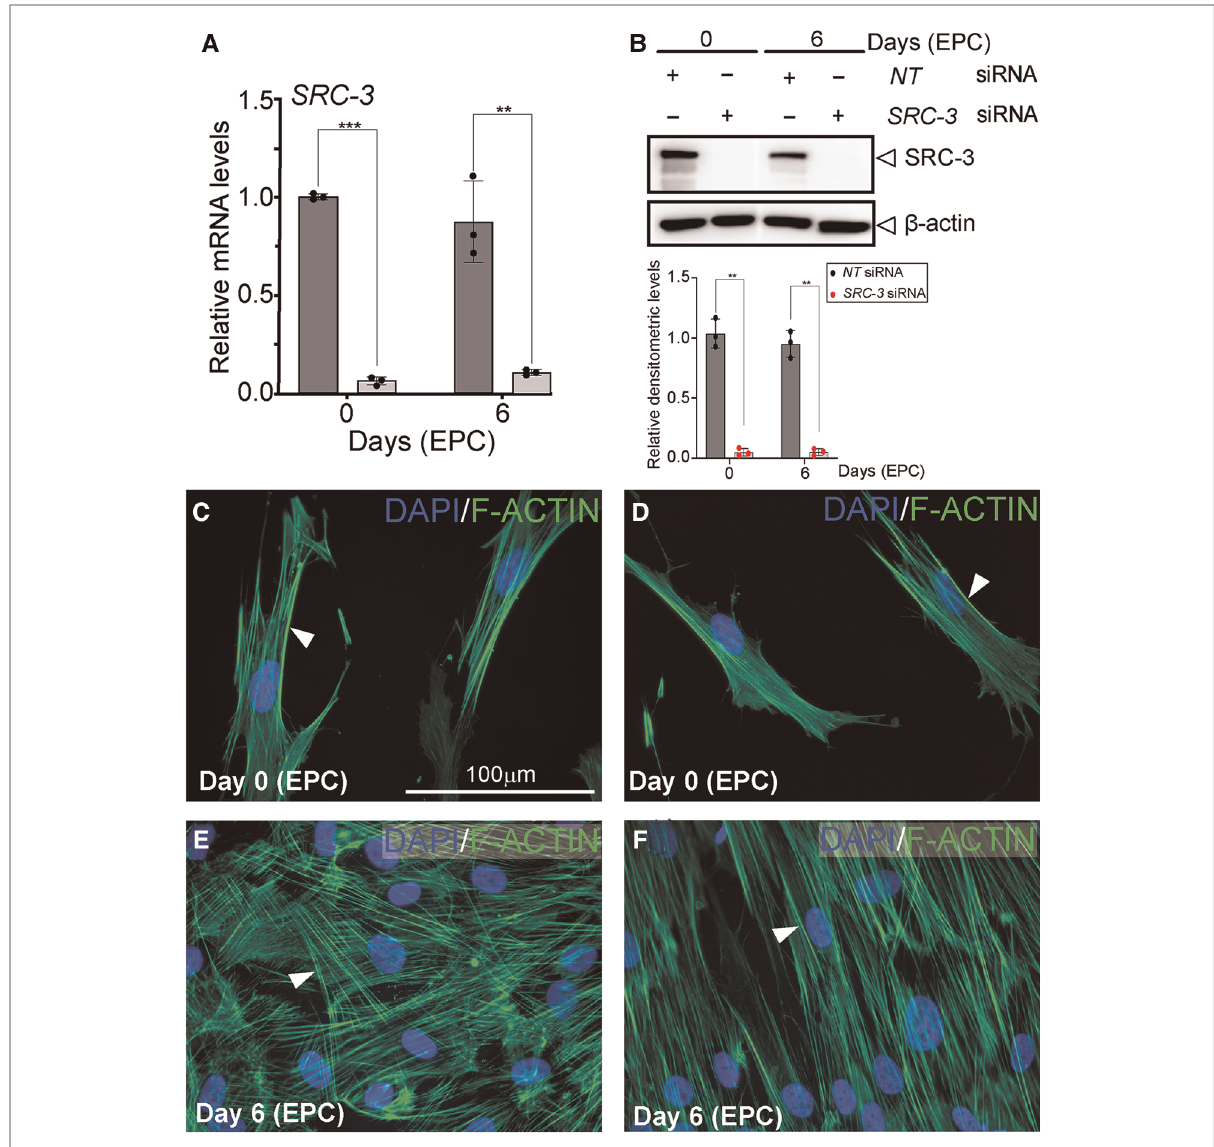
FIGURE 3 Decidualization of T-HESCs requires SRC-3 expression ( A ) siRNA mediated knockdown effectively reduces SRC-3 levels in T-HESCs both at day 0 and day 6 of EPC culture. The histogram ’ s dark grey bar on the left indicates T-HESCs transfected with NT siRNAs whereas the light grey bars on the right denote T-HESCs transfected with SRC-3 siRNAs. Note the persistent knockdown of SRC-3 from day 0 to day 6 of EPC culture. ( B ) Top panel shows that the western data con fi rm the results shown in ( A ). Note the signi fi cant knockdown of SRC-3 protein to undetectable levels following transfection with siRNAs targeted to SRC-3 at day 0 and 6 of EPC treatment; β -actin serves as a loading control. Bottom panel shows that ImageJ analysis quantitatively con fi rms the western data shown in the top panel. The black and red dots for each bar in the histogram represent the number of technical replicates per time point/treatment group. Error bars denote a mean average of densitometric intensity per time point/ treatment group±standard deviation (SD); ** denote a p -value ≤ 0.01. ( C,D ) show T-HESCs at day 0 of EPC treatment that are transfected with siRNAs targeting NT or SRC-3 respectively. Cells were immuno fl uorescently stained with DAPI (blue nuclei) and phalloidin [green fi bers; binds F- actin (arrowhead)]. Note the typical parallel arrangement of F-actin fi laments in the pre-decidual fi broblastic T-HESCs at this early stage of EPC culture. ( E ) and ( F ) display T-HESCs at day 6 EPC treatment, which were transfected with siRNAs targeting NT and SRC-3 respectively. Note in ( E ) the expected spatial disorganized pattern of F-actin fi laments in NT siRNA transfected T-HESCs as cells transform from a fi broblastoid to an epithelioid decidual cell morphology following six days of EPC culture. ( F ) Under similar culture conditions in ( E ), T-HESCs transfected with siRNAs targeting SRC-3 fail to show this F-actin disorganized pattern and continue to display the ordered F-actin parallel pattern as observed in the pre-decidual stromal fi broblast shown in [ D (white arrowhead)]. Scale bar in ( C ) applies to ( D – F